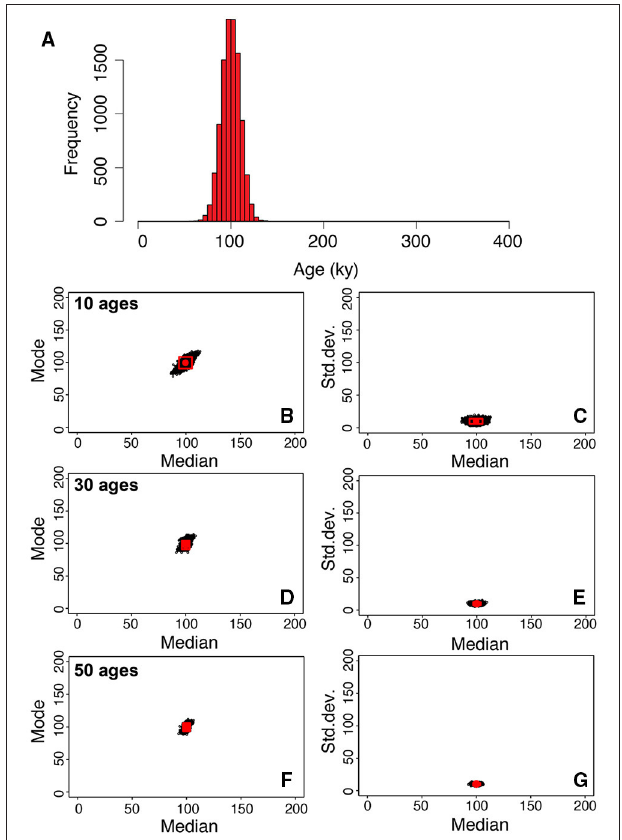
FIGURE 7 | (A) Normal distribution of ages characterized by a modal and median values of 100 ky and a standard deviation of 10 ky. (B,D,F) Each black point in the panels shows the values of mode, median, and standard deviation obtained by bootstrapping of the population of zircon crystallization times represented in (A) . Distributions of the values of mode and median obtained by sampling the distribution reported in (A) , 10, 30, and 50, times respectively. The procedure has been repeated 10,000 times for each subsample of 10, 30, and 50 ages. (C,E,G) Distributions of the values of standard deviation and median obtained by sampling the distribution reported in (A) , 10, 30, and 50 times, respectively. The red boxes provide the 95% confidence intervals for mode, median, and standard deviation.